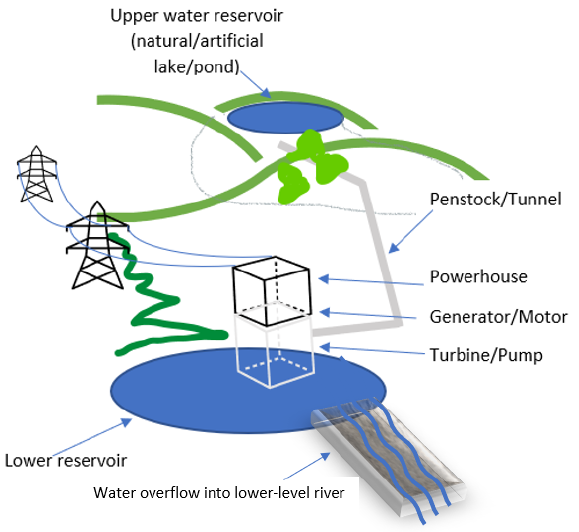
Figure 6. Pumped-storage hydropower, open loop.